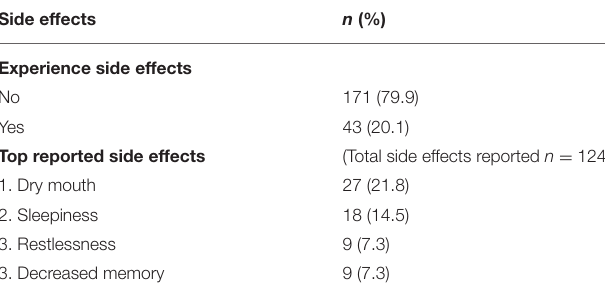
TABLE 8 | Information on side effects experienced by patients after 6 weeks of medical cannabis treatment. Side